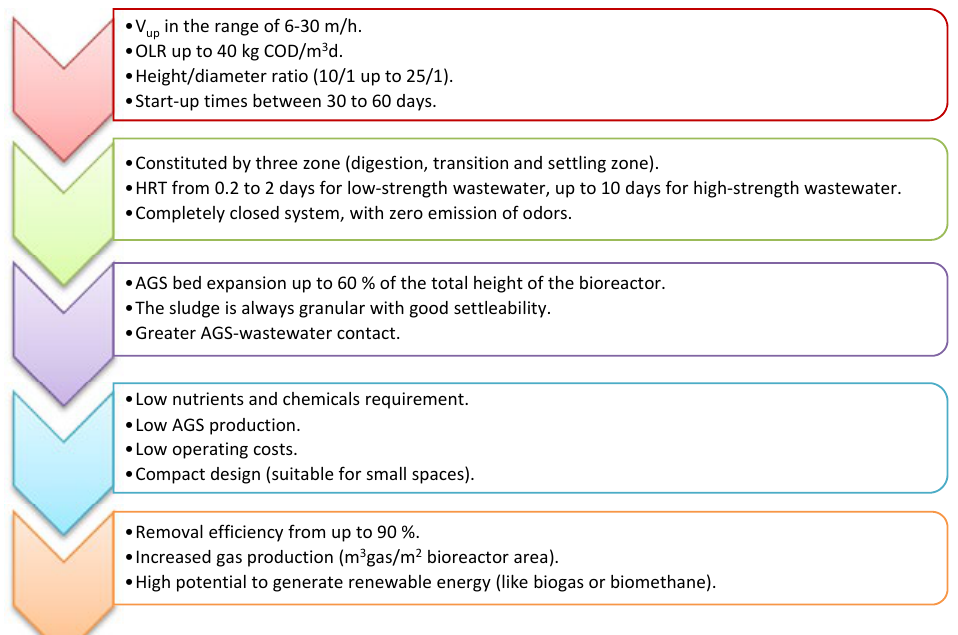
Fig. 2: Main characteristics of EGSB bioreactor